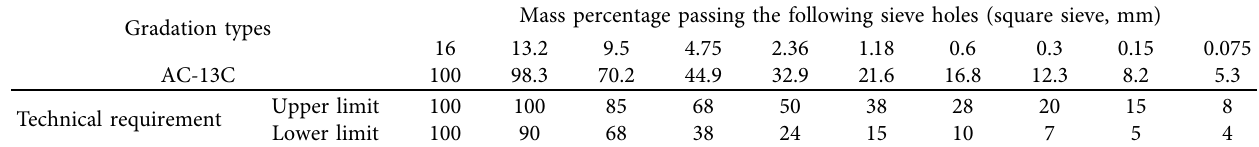
Table 4: Gradation of asphalt